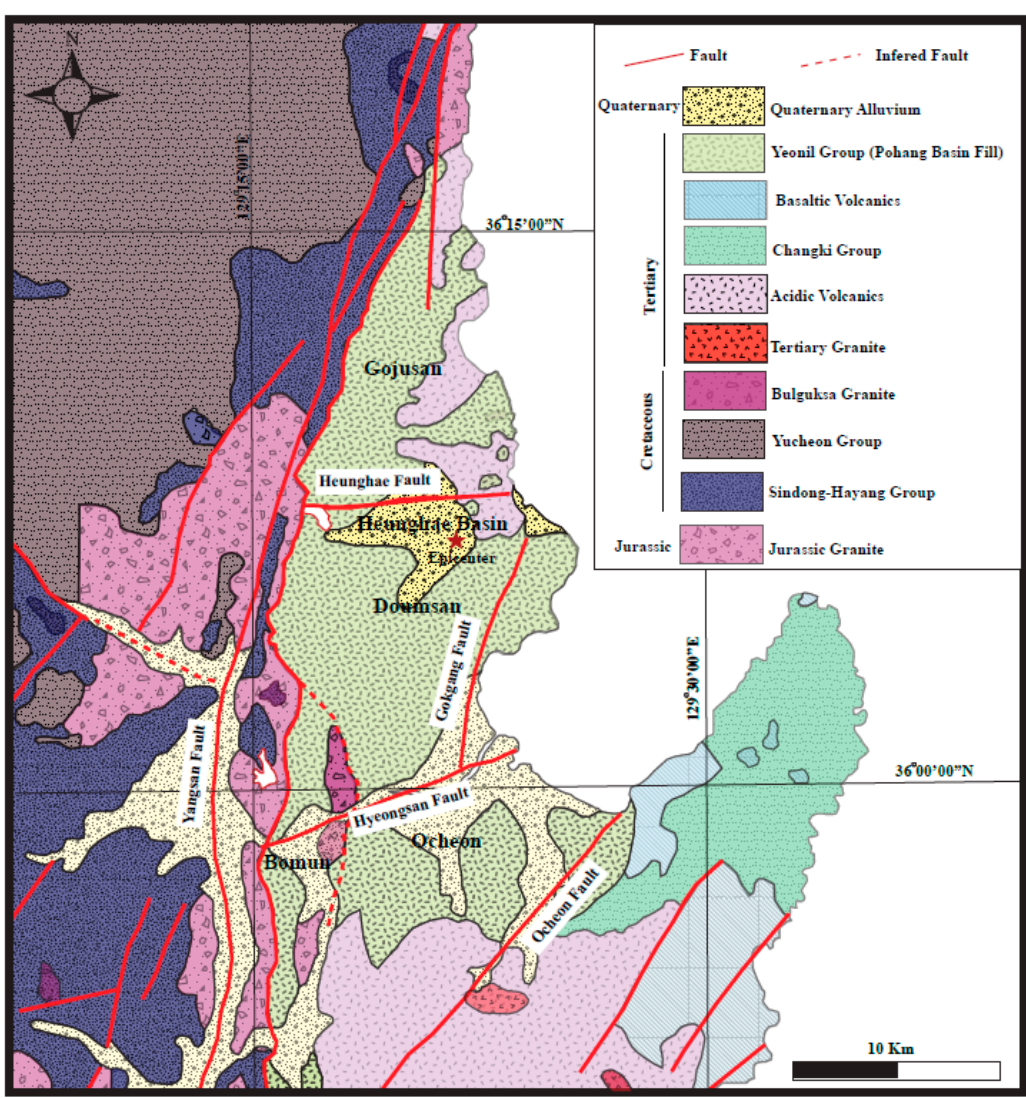
Figure 2. Geological and tectonic map of the study area showing major geological structures and lithological units (Modified from